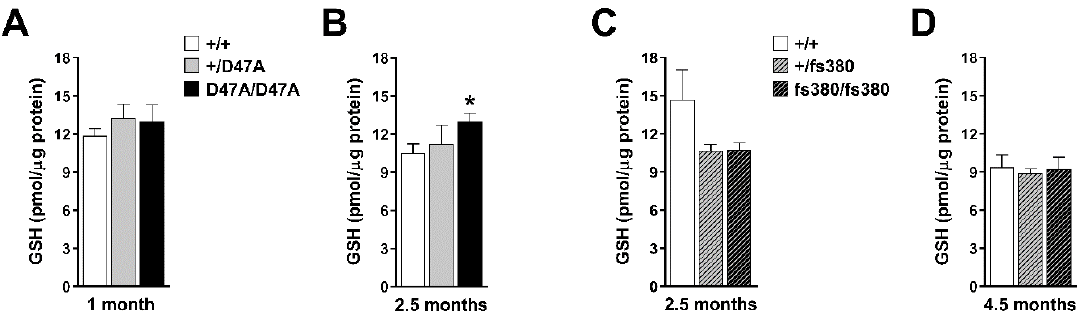
Figure 1. Levels of reduced glutathione (GSH) in Cx50D47A and Cx46fs380 lenses. ( A , B ) Graphs show the levels of GSH in 1- (A) and 2.5- (B) month-old wild-type ( +/+ ), and heterozygous ( +/ D47A) and homozygous (D47A / D47A) Cx50D47A mice. ( C , D ) Graphs show the levels of GSH in 2.5- ( C ) and 4.5- ( D ) month-old wild-type ( +/+ ) and heterozygous ( +/ fs380) and homozygous (fs380 / fs380) Cx46fs380 mice. Data are presented as the mean (bar) + standard error of the mean (n = 3 for 1-month-old and n = 4 for 2.5-month-old Cx50D47A lenses; n = 3 for 2.5-month-old and n = 4 for 4.5-month-old Cx46fs380 lenses). The asterisk denotes a significant di ff erence compared with wild-type